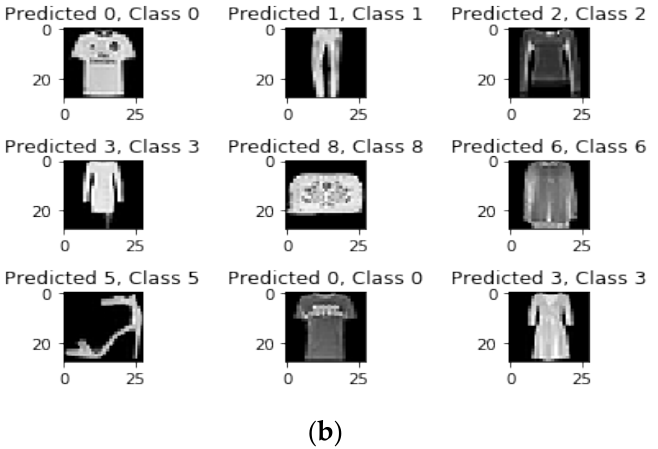
Figure 5. ( a ) model summary ( b ) MNIST output.